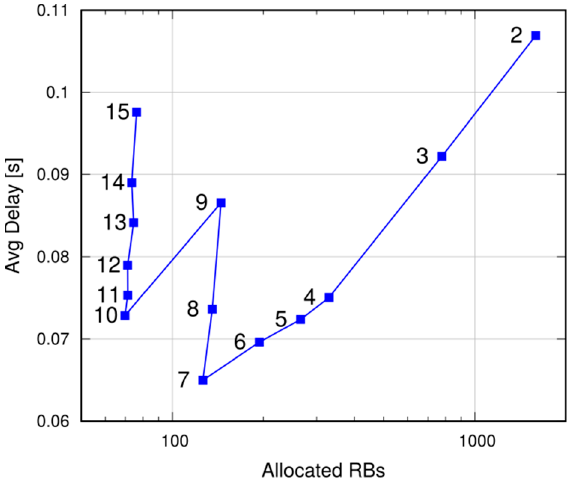
Figure 15. Average allocated RBs and average delay as a function of CQI (Channel Quality Indicator).